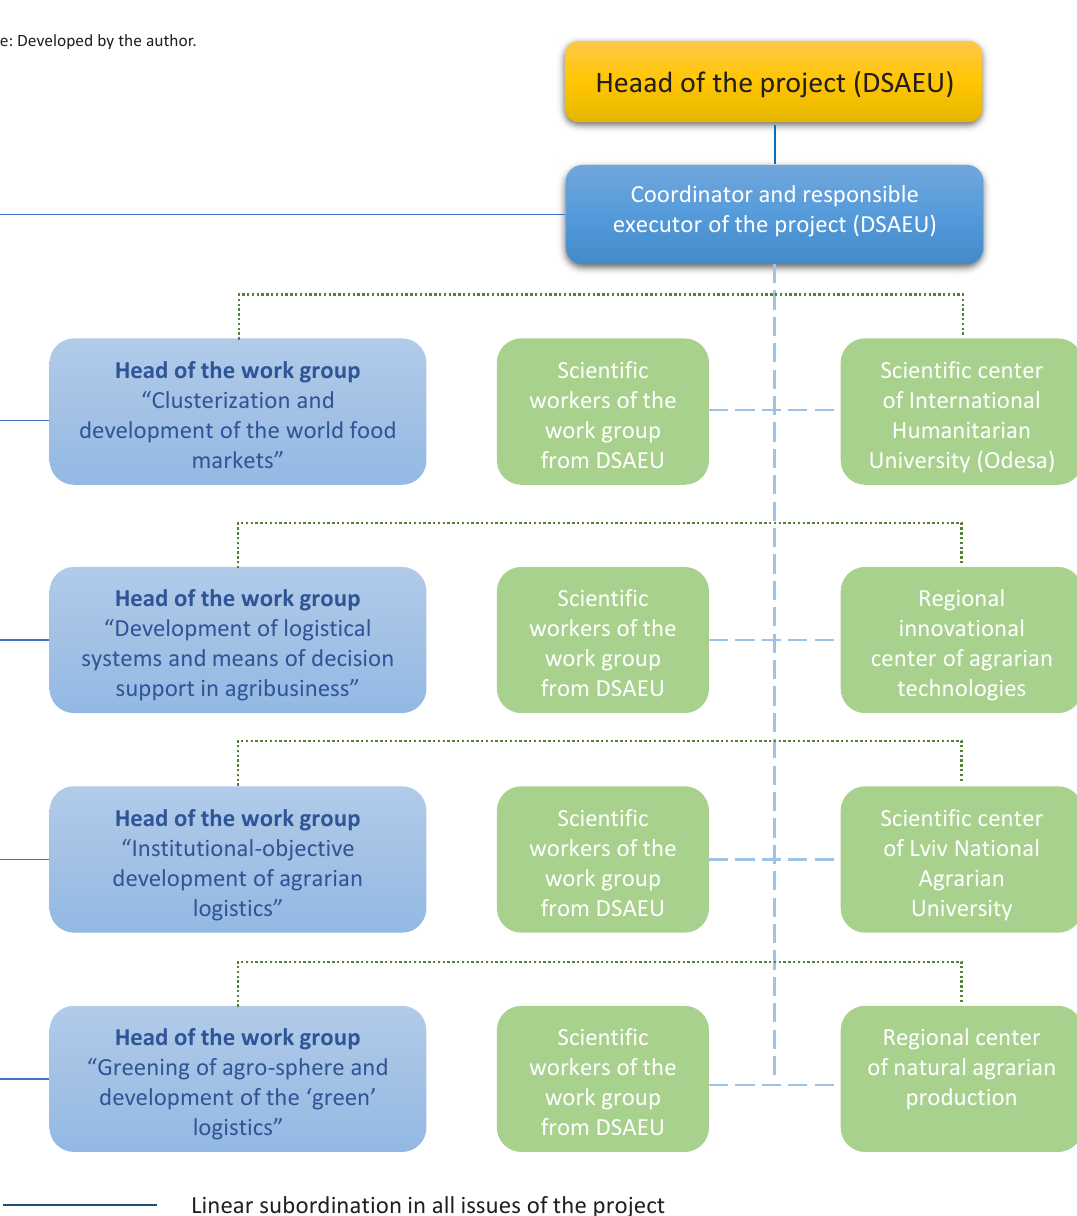
Figure. 3. The model of the matrix structure of managing the implementation of the scientific project “Management of the development of agricultural markets, agrarian and ecological logistics in